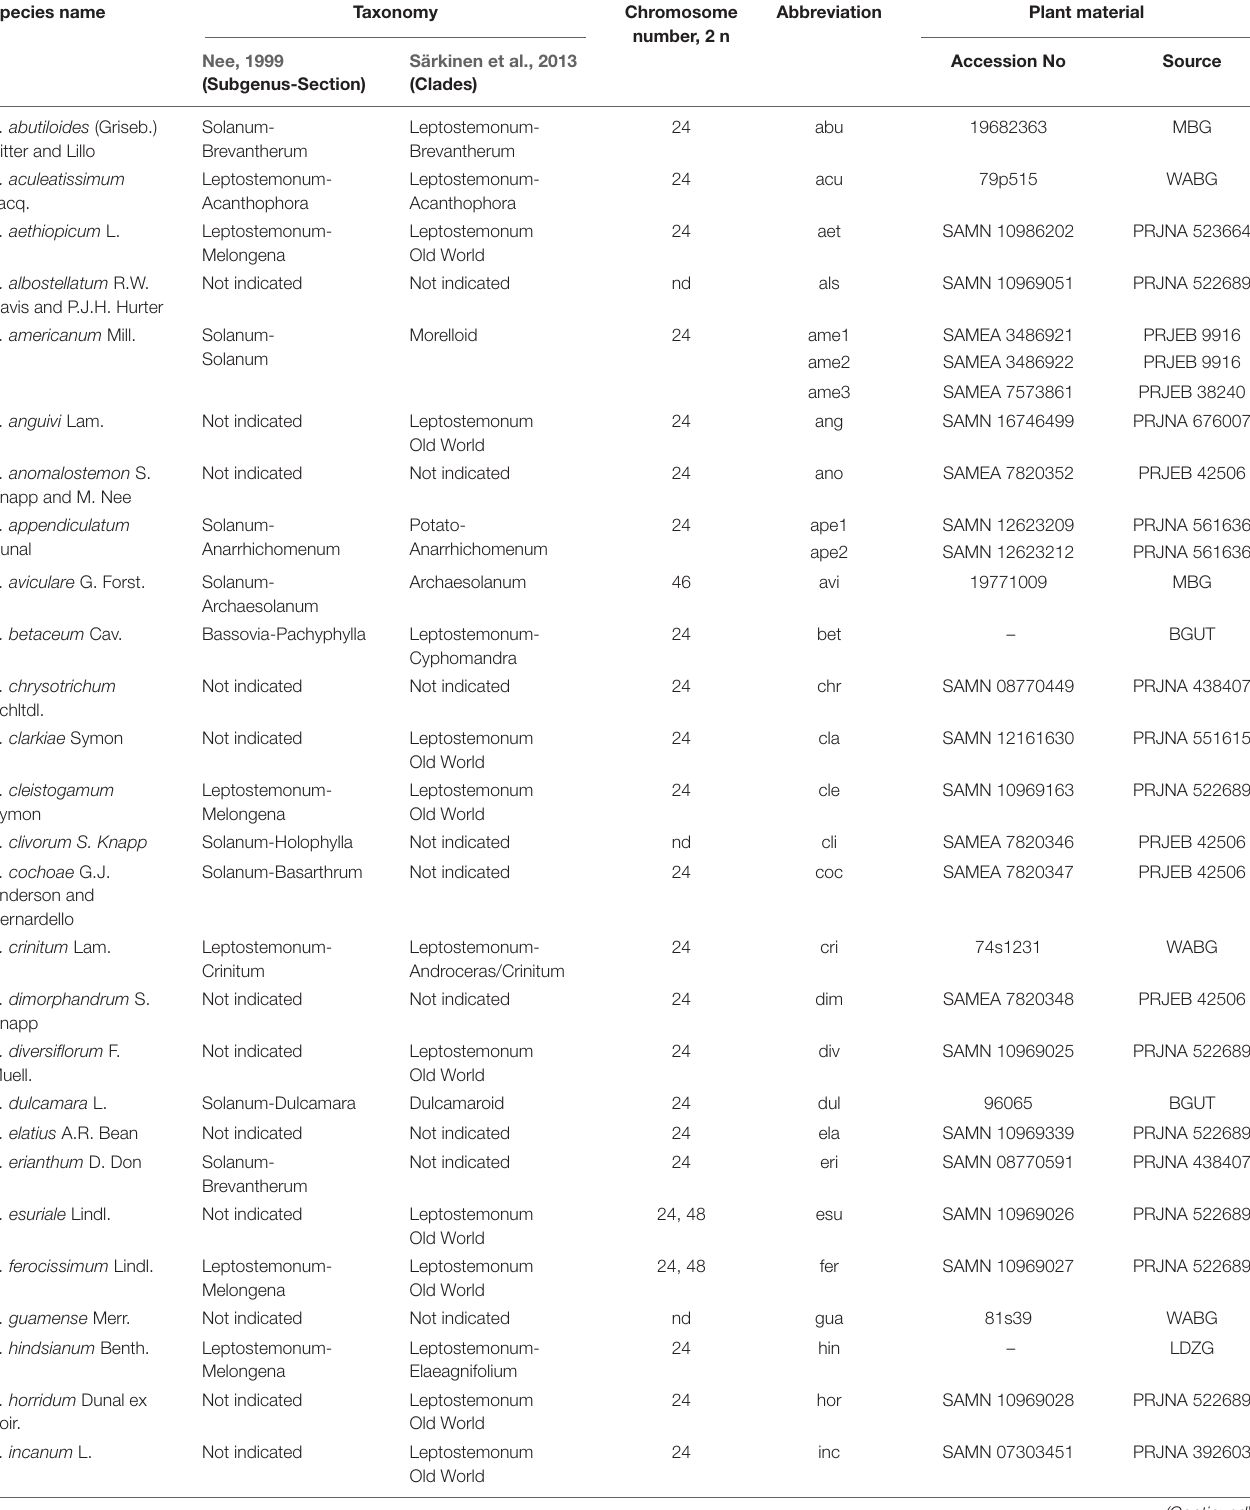
TABLE 1 | List of Solanum species analyzed (excluding sect. Petota